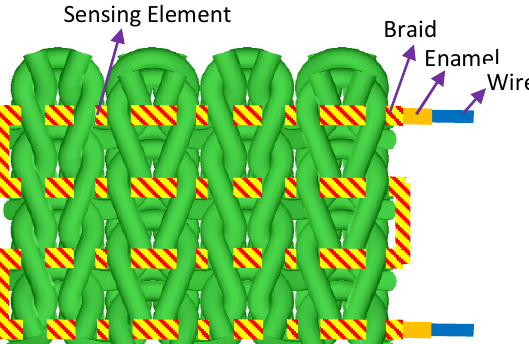
Sensing Element